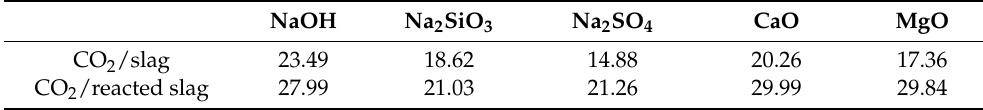
Table 3. CO 2 uptake of alkali-activated slag samples (g/100